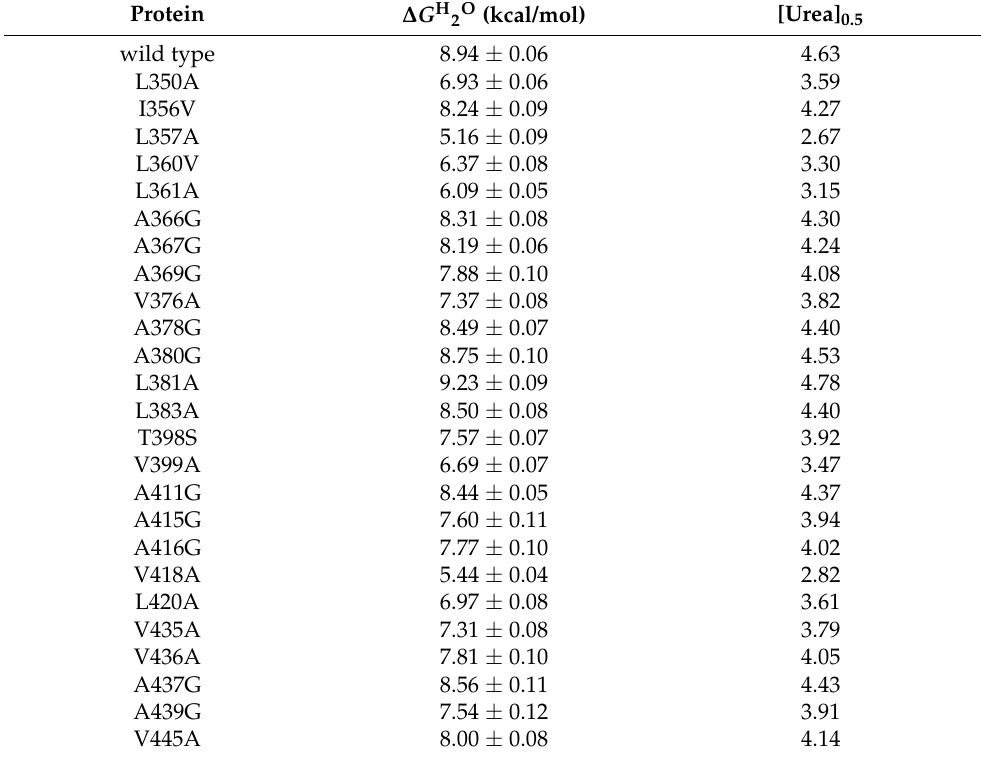
Urea-induced unfolding equilibrium data were obtained at 20 ◦ C in 20 mM of Tris HCl, pH = 7.5, containing 0.2 M of NaCl and 200 µ M of DTT by measuring circular dichroism ellipticity at 222 nm [ θ ] 222 . ∆ G H 2O